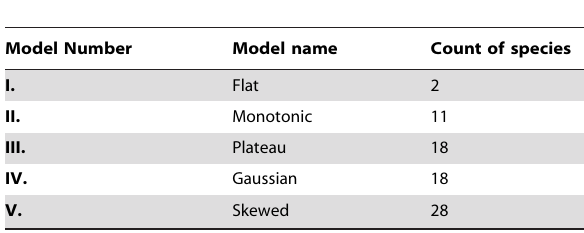
Table 1. Number and type of species’ elevational